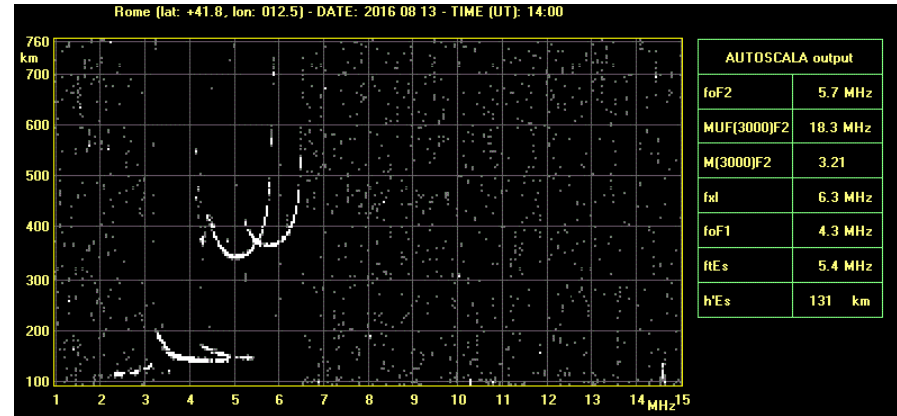
Figure 1. Ionogram recorded by the Advanced Ionospheric Sounder (AIS-INGV) ionosonde of Rome on 13 August 2016, 14:00 UT, during the ionospheric anomaly associated with the 30 October 2016 EQ. The outputs of the Autoscala software for automatic interpretation of ionograms are reported on the right.